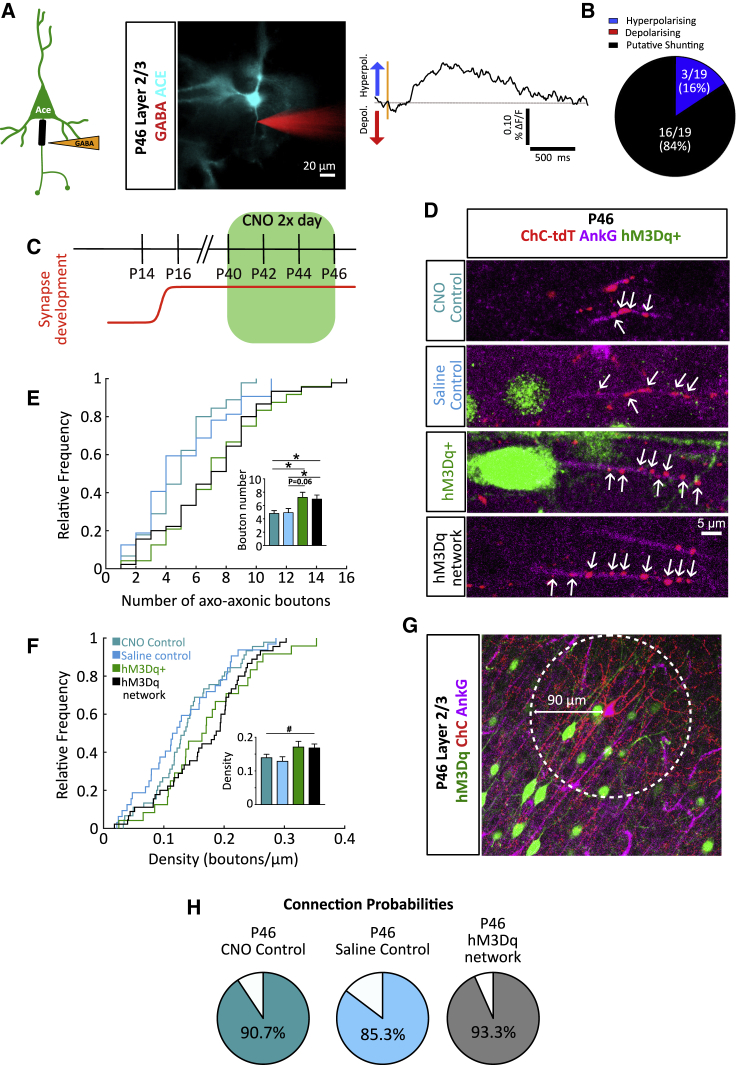
Axo-axonic Plasticity Matches Developmental Changes in GABAergic Polarity(A) Left, schematic and example image of iontophoresis experiment. A pipette containing GABA was placed near the soma (pipette in red) of a pyramidal neuron expressing Ace2N-mNeon (cyan). Right, example hyperpolarizing voltage response obtained from imaging somatic responses to iontophoretic GABA application (orange area) at the soma of a P46 pyramidal cell.(B) Classification of responses into hyperpolarizing (blue), depolarizing (red), and putative shunting (black) for all cells tested.(C) Timeline for CNO delivery in adult mice.(D) Example images of axo-axonic boutons in the different conditions at P46.(E and F) Cumulative distribution and average axo-axonic bouton number (E) and density (F) (# denotes p < 0.05 for one-way ANOVA without reaching significance in post hoc comparisons; ∗p < 0.05 denotes Kruskal-Wallis and Dunn’s post hoc comparisons test, n = 44–72 neurons per condition, 3–5 mice, per condition).(G and H) Example image (G) and connection probabilities (H) within a 90 μm radius (white circle) at P46 (chi-square test, n = 150–180 AISs, 3–4 mice, per condition). Bar plots show mean ± SEM.See also Figures S4–S6.